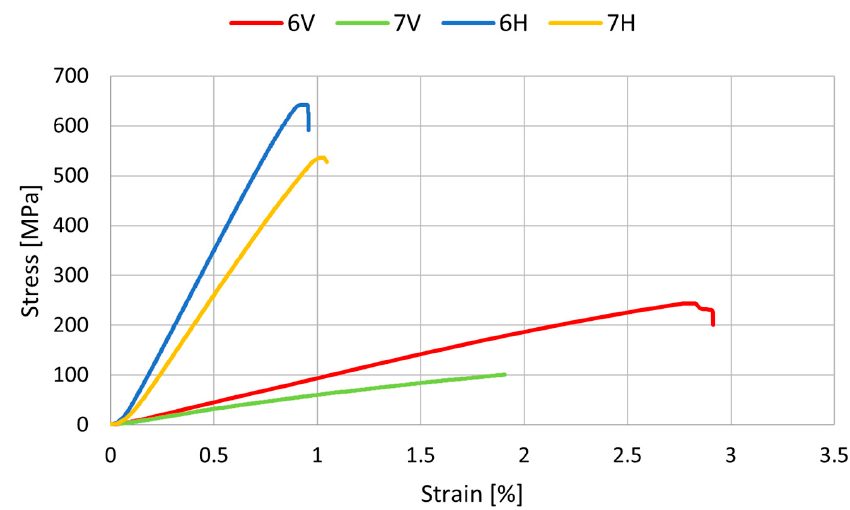
Figure 5. Representative curves for samples with 300 mm long carbon